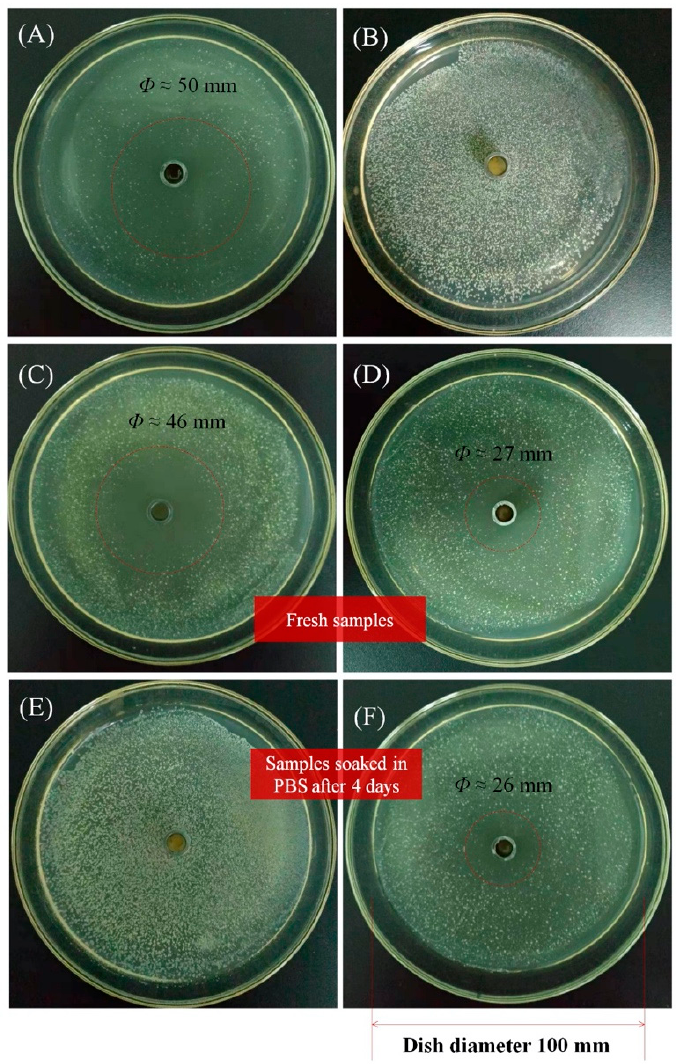
Figure 6. Antibacterial properties of different samples against S. aureus . ( A ) CEO solution (2 mg/mL) in ethanol, ( B ) zein film containing blank MCM-41, ( C ) fresh CEO/zein film, ( D ) fresh film nanocomposite, ( E ) CEO/zein film soaked in neutral PBS solution for four days and a ( F ) film nanocomposite soaked in neutral PBS solution for four days.